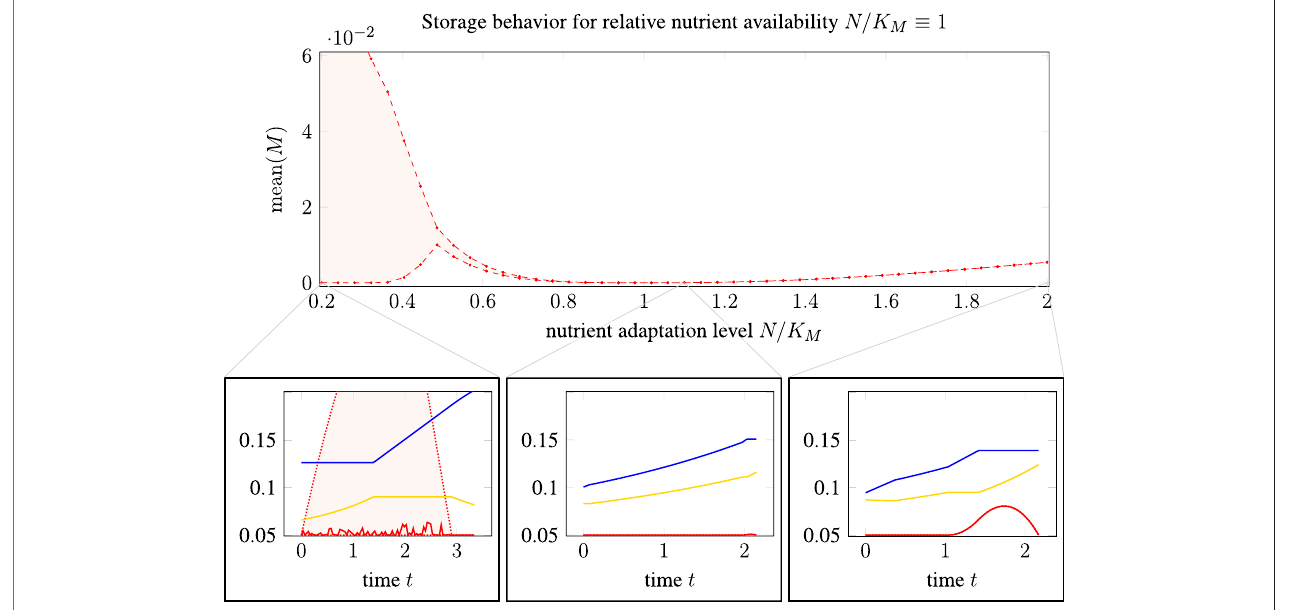
FIGURE 5 | In fl uence of optimistic and pessimistic goal states in cell doubling: Main plot: mean relative storage accumulation, see (3.1) , as a function of nutrient adaptationlevel.Bottomrow:Threeselectedtimecourses,cf. Figure4 ,fornutrientadaptationlevels N/K M of0.2,1.1,and2.0.For N/K M < 1,thequantity mean ( M )isno longer unique such that a shaded area indicates the possible range, as TOA-VA also predicts a range of possible solutions (shaded area in the bottom left plot).